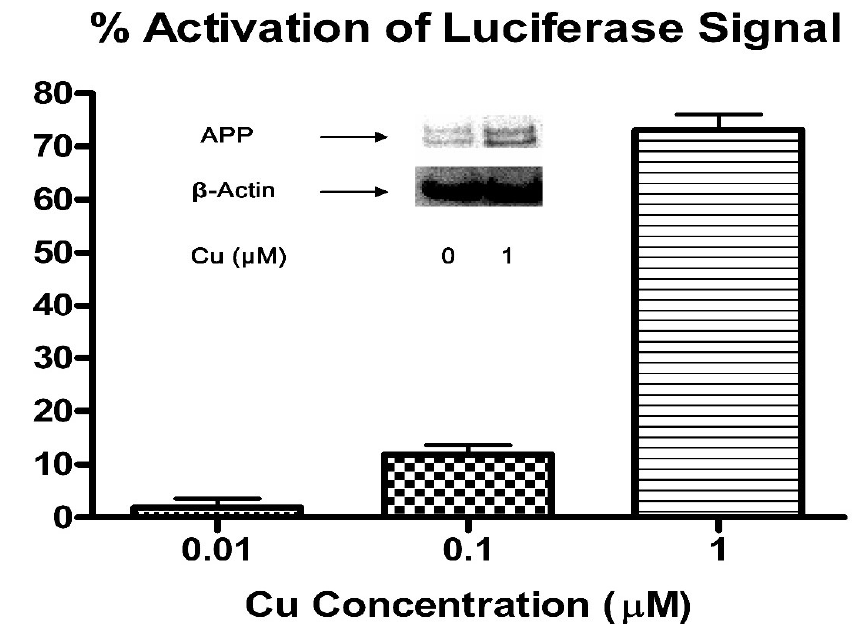
Figure 2. Cu 2 + treatment increased APP protein expression in human SH-SY5Y neuroblastoma cells via 5 (cid:48) UTR of APP mRNA. Human SH-SY5Y neuroblastoma cells stably transfected with APP 5 (cid:48) UTR driven luciferase reporter gene construct with GFP as an internal specificity control- pIRES(APP 5 (cid:48) UTR ) construct, were treated with Cu 2 + (0.01, 0.1, 1 µ M) for 48 h under regular culture condition (95% O 2 , 5% CO 2 , 95% humidity, 37 ◦ C). And then the luciferase substrate (Perkin Elmer, MA, USA) was added and incubated for 30 minutes for complete cell lysis. Luminescence was recorded on an LJL Analyst plate reader (Molecular Device, CA, USA). Percentage activation of luciferase signal was calculated relative to positive and negative controls. The data indicate mean ( ± SE, n = 5). Inset: Native SH-SY5Y cells were treated with Cu 2 + (0, 1 µ M) under same culture condition for 3 days. Cells were then washed and lysed, and endogenous expression levels of APP and the control protein- β -actin in lysates were probed by Western blotting.